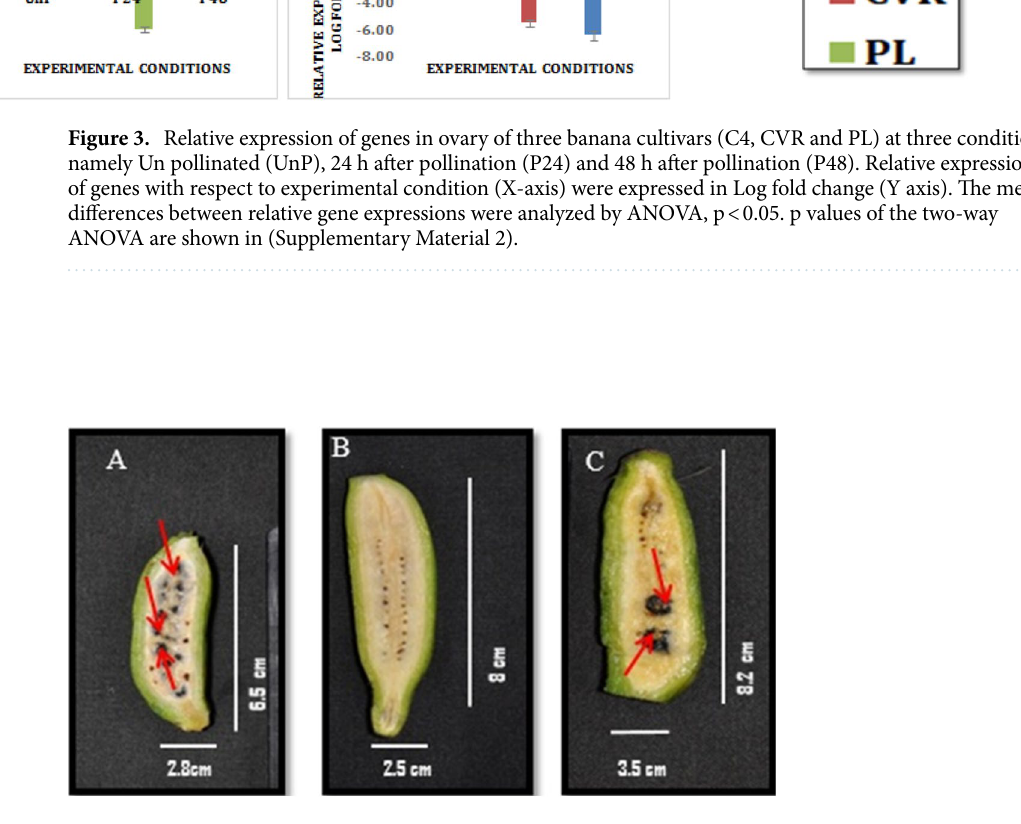
Figure 4. Fruit image of Musa spp. ( A ) C4 (IC no. 0642) profuse seed set, ( B ) PL (IC no. 0195) seldom setting seeds upon pollination, ( C ) CVR (IC no. 0638) parthenocarpic accession, upon pollination rarely setting seeds occurs respectively. Arrows indicate location of seeds in seeded accessions ( Musa